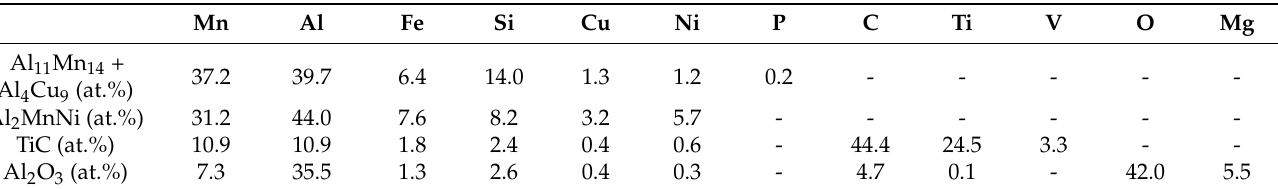
Table 4. Chemical composition of individual phases in the sample sintered at 900 °C.